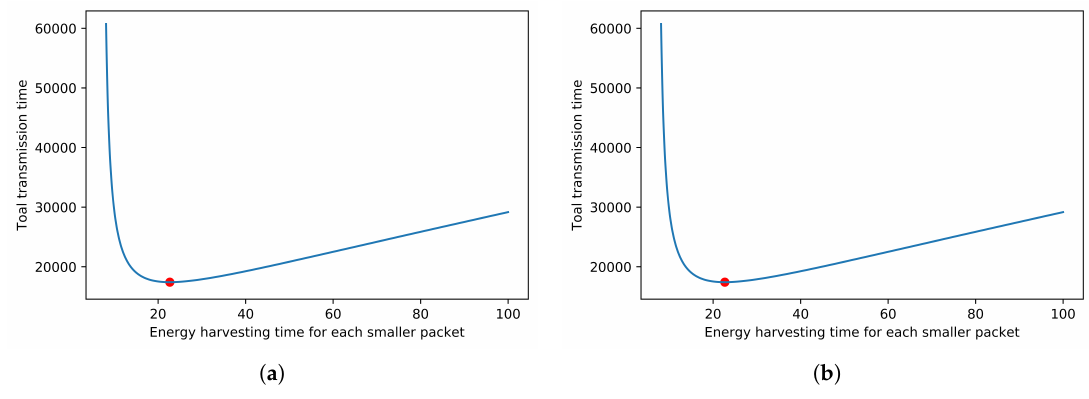
Figure 4. Find the minimum total transmission time. ( a ) header = 3. ( b ) header =